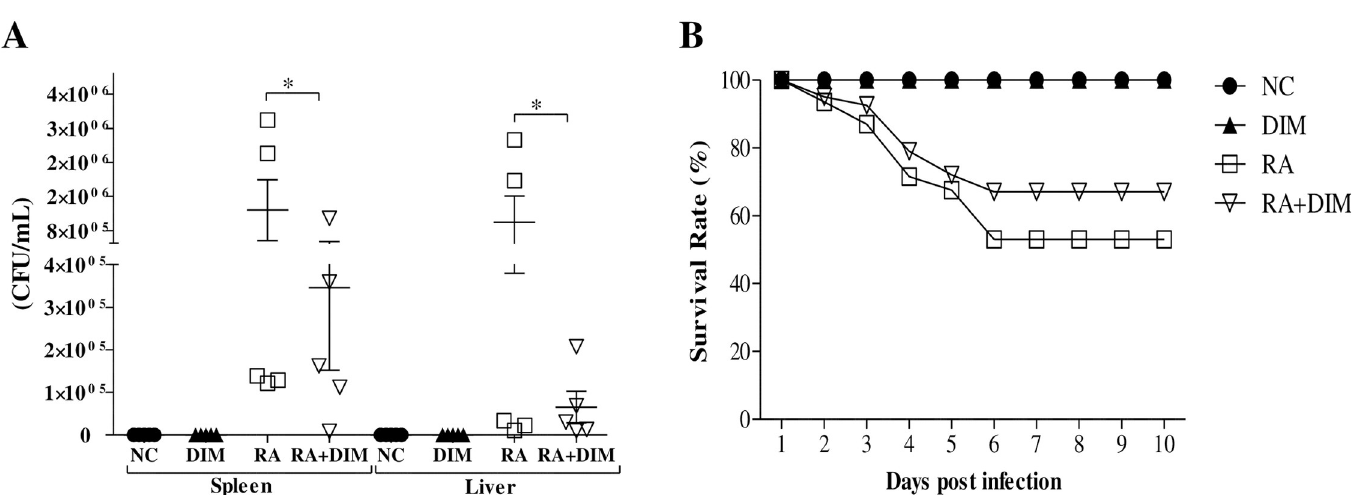
Fig 2. DIM treatment attenuates R . anatipestifer infection in ducks. (A) Bacterial load in the spleens and livers. Two-week-old ducks were inoculated intramuscularly with 5 × 10 7 CFU of R . anatipestifer serotype 7 and treated orally with DIM (200 mg/kg/day) from 1 day prior to infection throughout the experiment. Five ducks were sacrificed at 4 dpi, and the spleen and liver were aseptically removed for bacterial recovery. Data on bacterial recovery represent the mean ± SE of five birds and one representative of two independent experiments. � P < 0.05 for comparison of the infected/untreated group (RA) with the infected/treated group (RA + DIM). (B) Survival rate of ducks (n = 25/group). The survival rate of control and treated ducks was recorded every day for 10 days. Data represent one representative of two independent experiments. NC, uninfected healthy control; RA, R . anatipestifer ; DIM, 3,3’-diindolylmethane; CFU, colony formation unit.